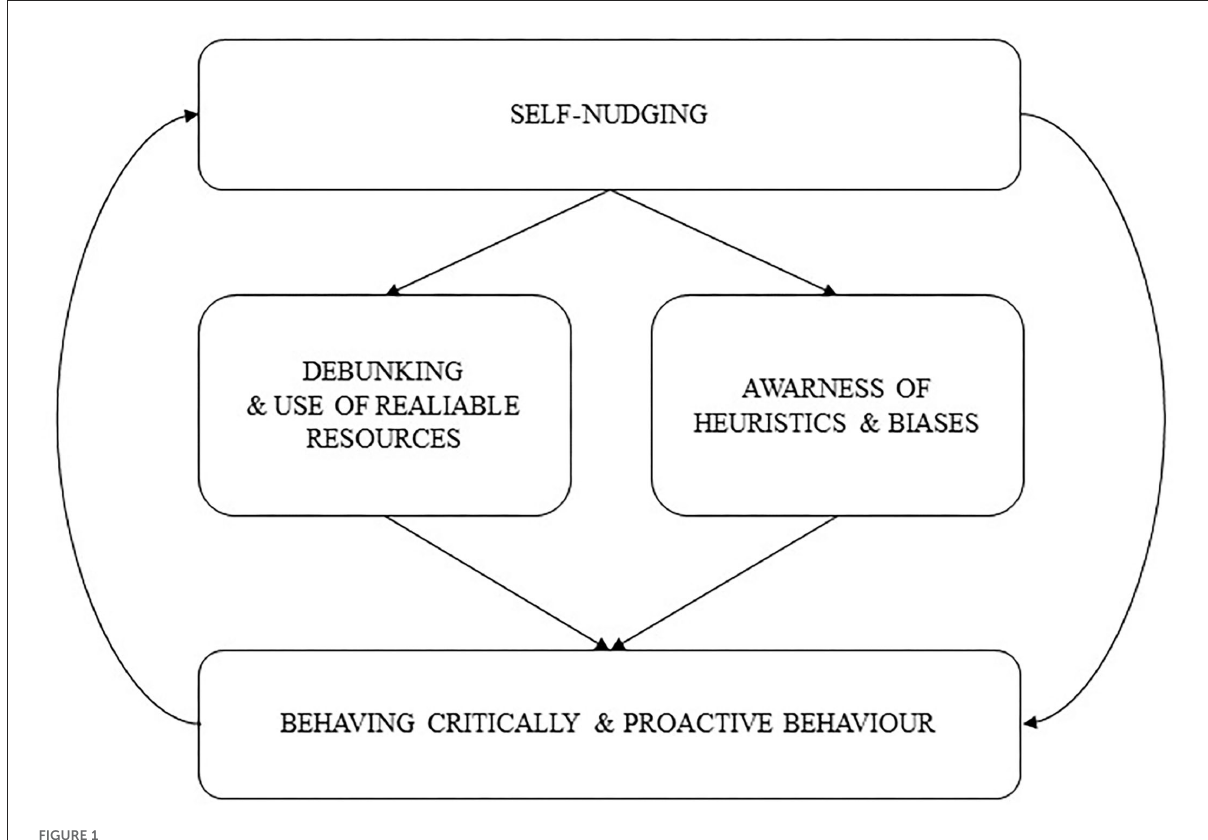
FIGURE1 Self-nudging circuit of behaving and thinking